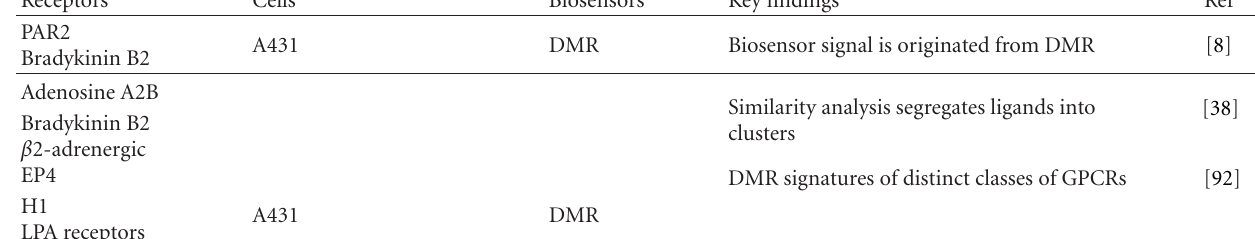
Table 1: Receptors, cell lines, and technologies and key points of the studies related to the use of label-free cellular assays for GPCRs.